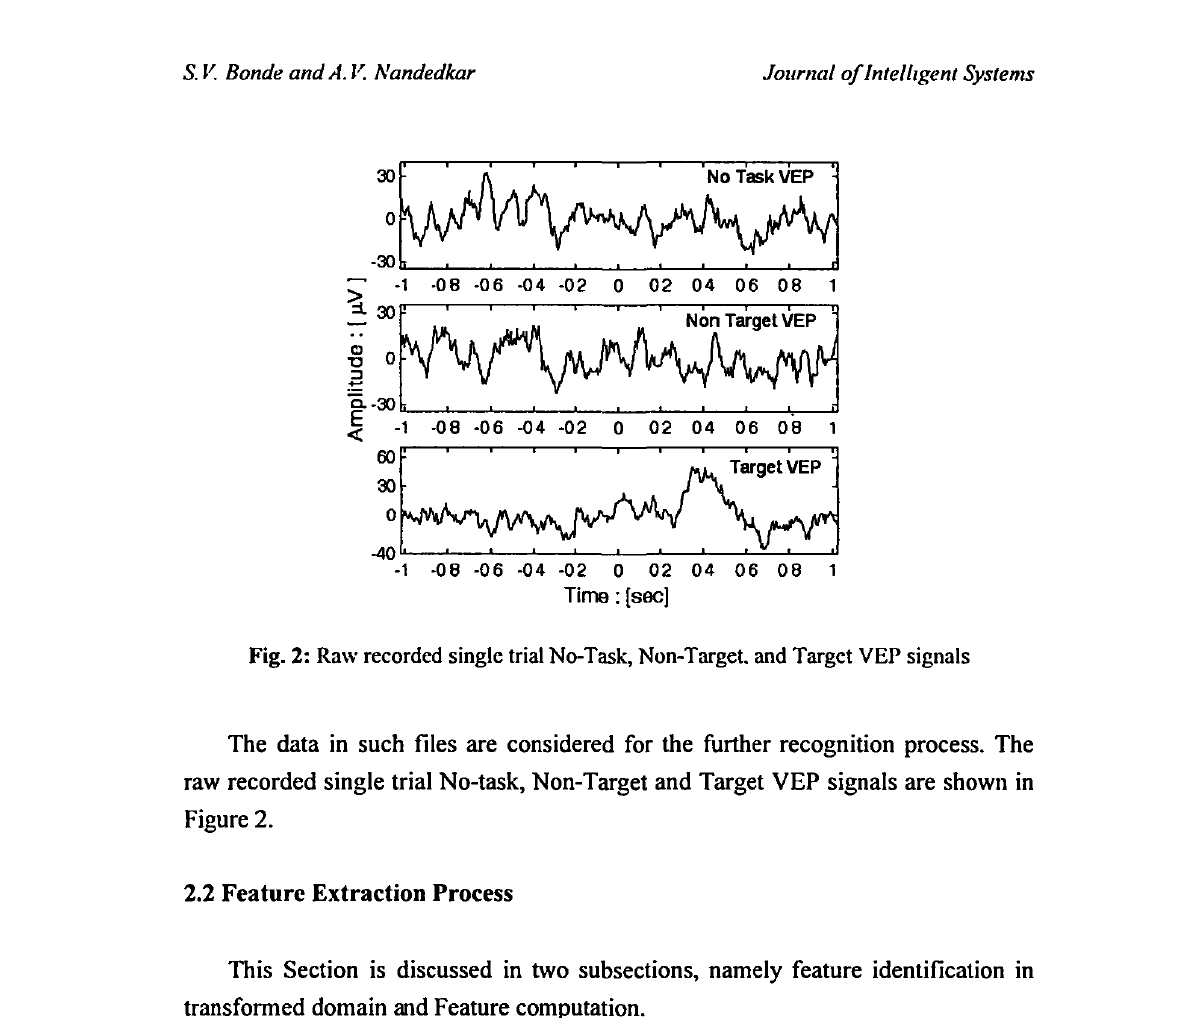
Fig. 2: Raw recorded single trial No-Task, Non-Target, and Target VEP